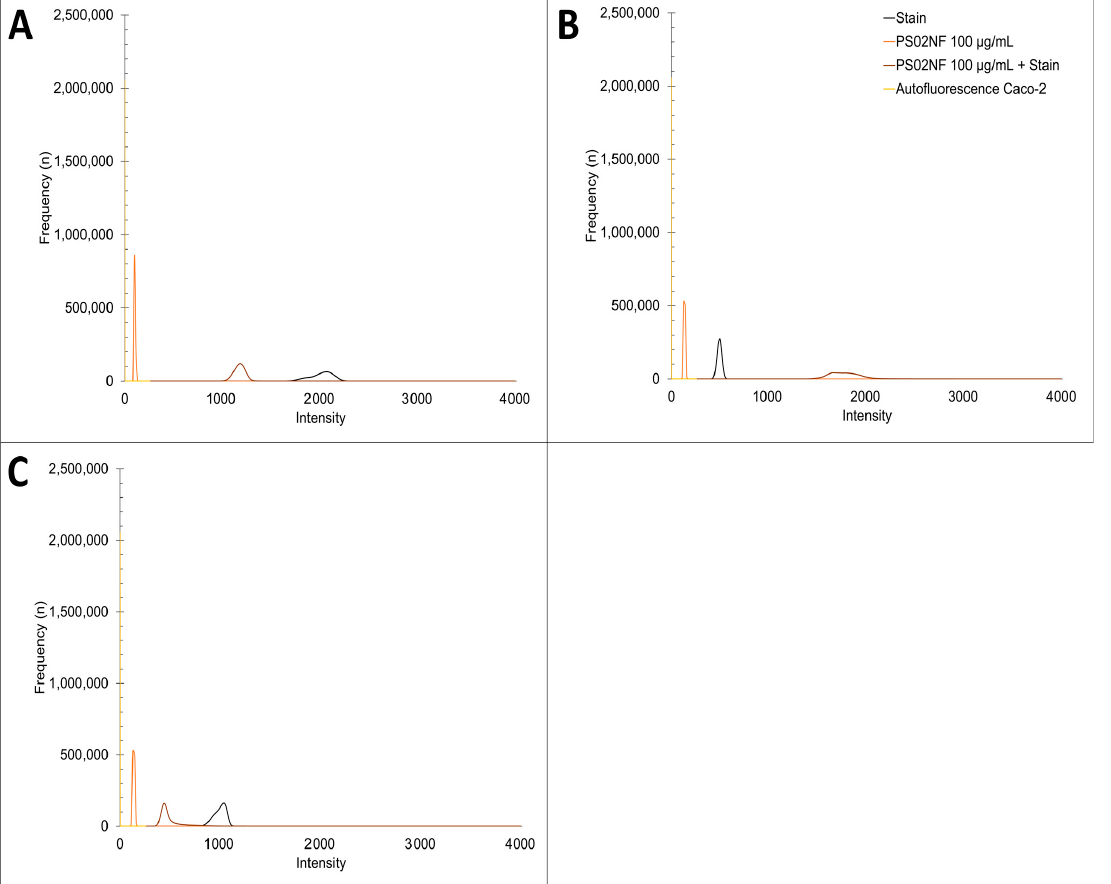
Figure A1. Autofluorescence of Caco-2 monolayer and particle interference with stain. Fluorescence intensities of stain in phosphate-buffered saline (PBS), PS02NF 100 µg/mL in PBS, PS02NF 100 µg/mL with stain in PBS, and caco-2 monolayer for ( A ) Peroxy-orange 1 (PO-1) ( B ) MitoTracker Red CMXRos and ( C ) MitoSOX were assessed with confocal laser scanning microscopy (LSM900, Zeiss, Zaventem, Belgium) and ZEN Blue 3.1 software (Zeiss, Zaventem, Belgium) at Ex/Em: 543/545–750.